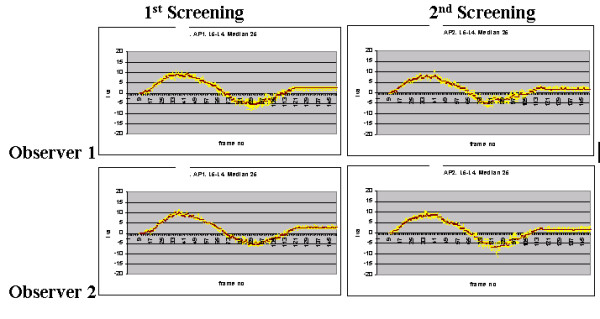
Example of L4-5 intervertebral angle series of 120 frames in sidebending; 2 screenings 30 minutes apart, analysed by 2 blinded observers. (Convention: left sidebending is +ve in graphs).